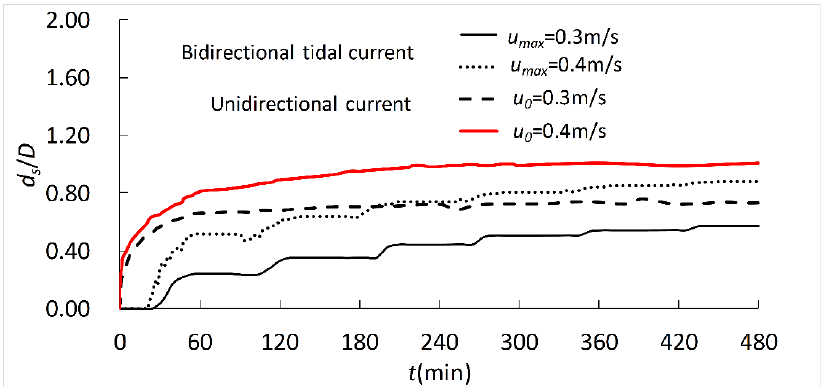
Figure 7. Time development of scour depth under bidirectional tidal currents.